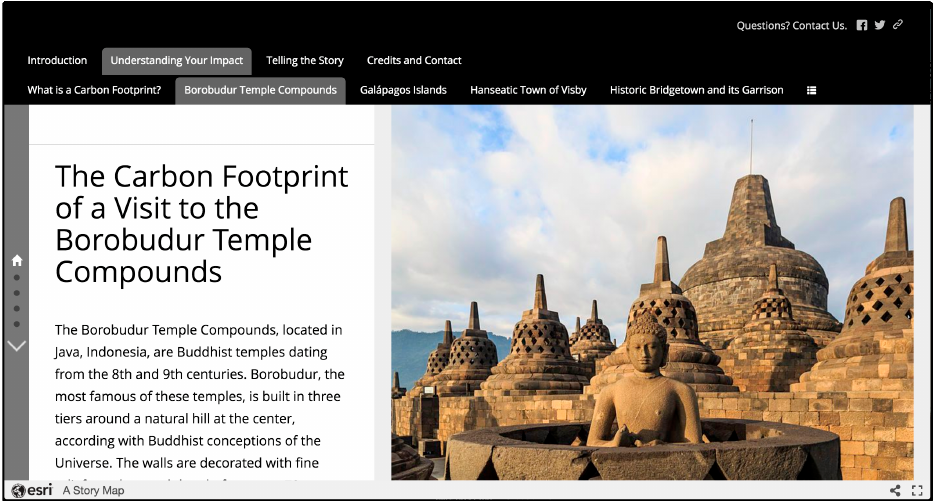
Figure 3. Webpage screenshot of Understanding Your Impact theme, with example of the site of the Borobudur Temple Compounds, in the StoryMap Climate Footprints of Heritage Tourism [41].